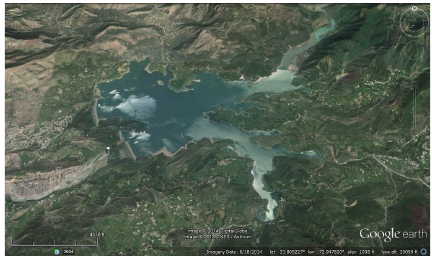
Figure 1: Locations map of the study area.